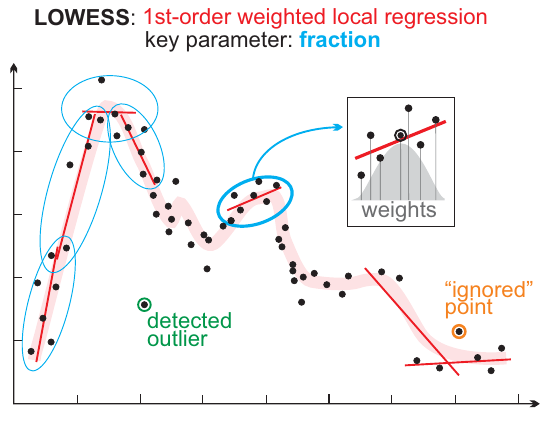
Figure 6. Principles of LOWESS (locally weighted scatterplot smoothing) method for a 1st-order polynomial. Black points are the source data; red narrow lines are the local regression solutions; the thick rose line is a final LOWESS solution. The gray area on the sub-panel represents a weight-defining